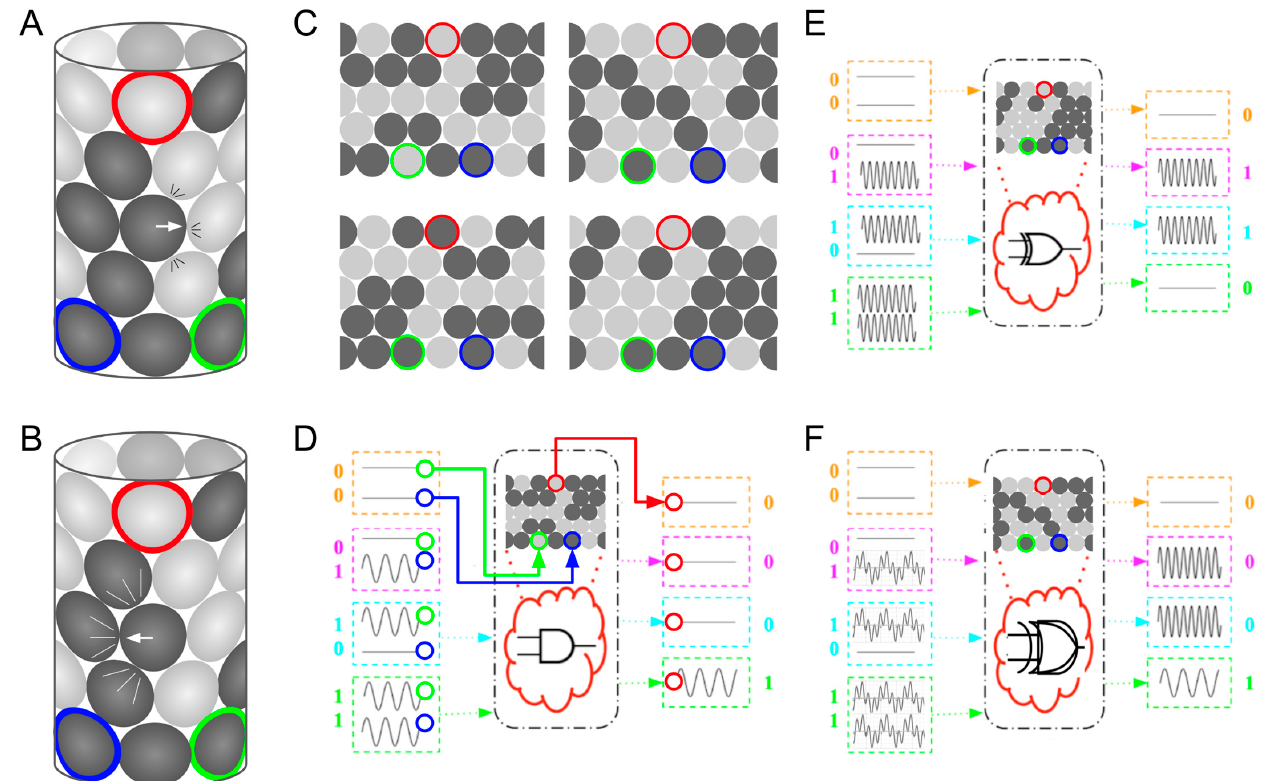
Figure 2. Engineering polycomputing materials. ( A ) A granular metamaterial can be assembled by embedding stiff (dark gray) and soft (light gray) particles into a sheet and wrapping it into a tub. If a particle collides with soft particles, it only slightly affects their motion. ( B ) If it hits rigid particles, their motion is affected more. ( C ) An evolutionary algorithm (EA) can be created that evolves populations of metamaterials, where each one has a unique combination of stiff and soft particles. The EA can then delete those metamaterials that perform poorly at some desired task, such as performing a computation, and make randomly modified copies of those that do a better job. ( D ) This can result in the evolution of a material that acts as an AND gate, a building block of computers: some designated ‘output’ particle (red) should only vibrate if two other ‘input’ particles are vibrated from outside the system (green and blue). ( E ) An evolutionary algorithm can be asked to evolve a metamaterial that acts as an AND at one frequency, but also to act as another computational building block, an XOR gate, at a higher frequency: the output particle should only vibrate if one of the input particles is vibrated. ( F ) This process results in the evolution of a polycomputing material: if inputs are supplied at two different frequencies, the evolved material acts as an AND and XOR gate simultaneously: it provides the results of these two computations at the same place at the same time (the output particle), but at different frequencies. Details can be found in [8].; panels ( D – F ) used with permission from ACM.